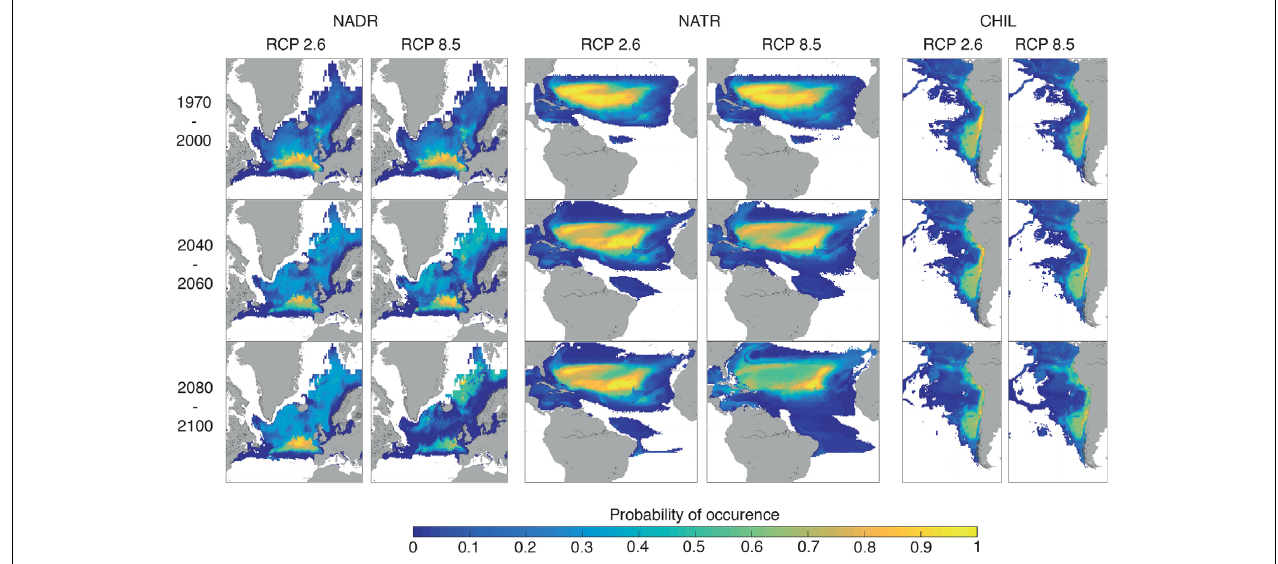
FIGURE 3 | Spatial distribution of the probability of occurrence of the following three BGCPs: North Atlantic Drift region (NADR), North Atlantic Tropical Region (NATR) and Chilean coast (CHIL). Mean ESMs and ENMs distribution of each province for the period 1970–2000, 2040–2060, and 2080–2100 are represented for both RCP 2.6 and